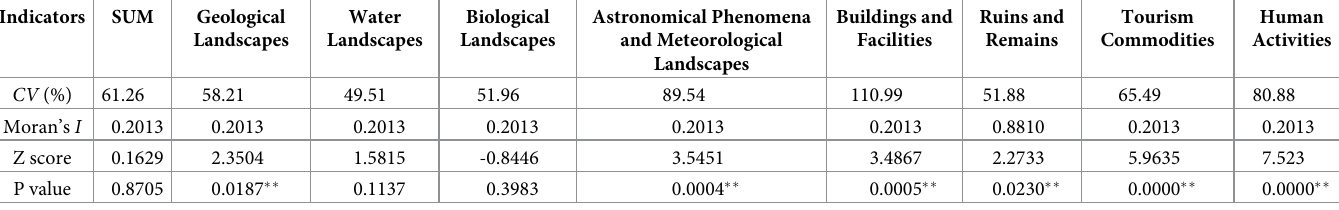
Table 2. The CV s and Moran’s I values of tourism resources on Hainan